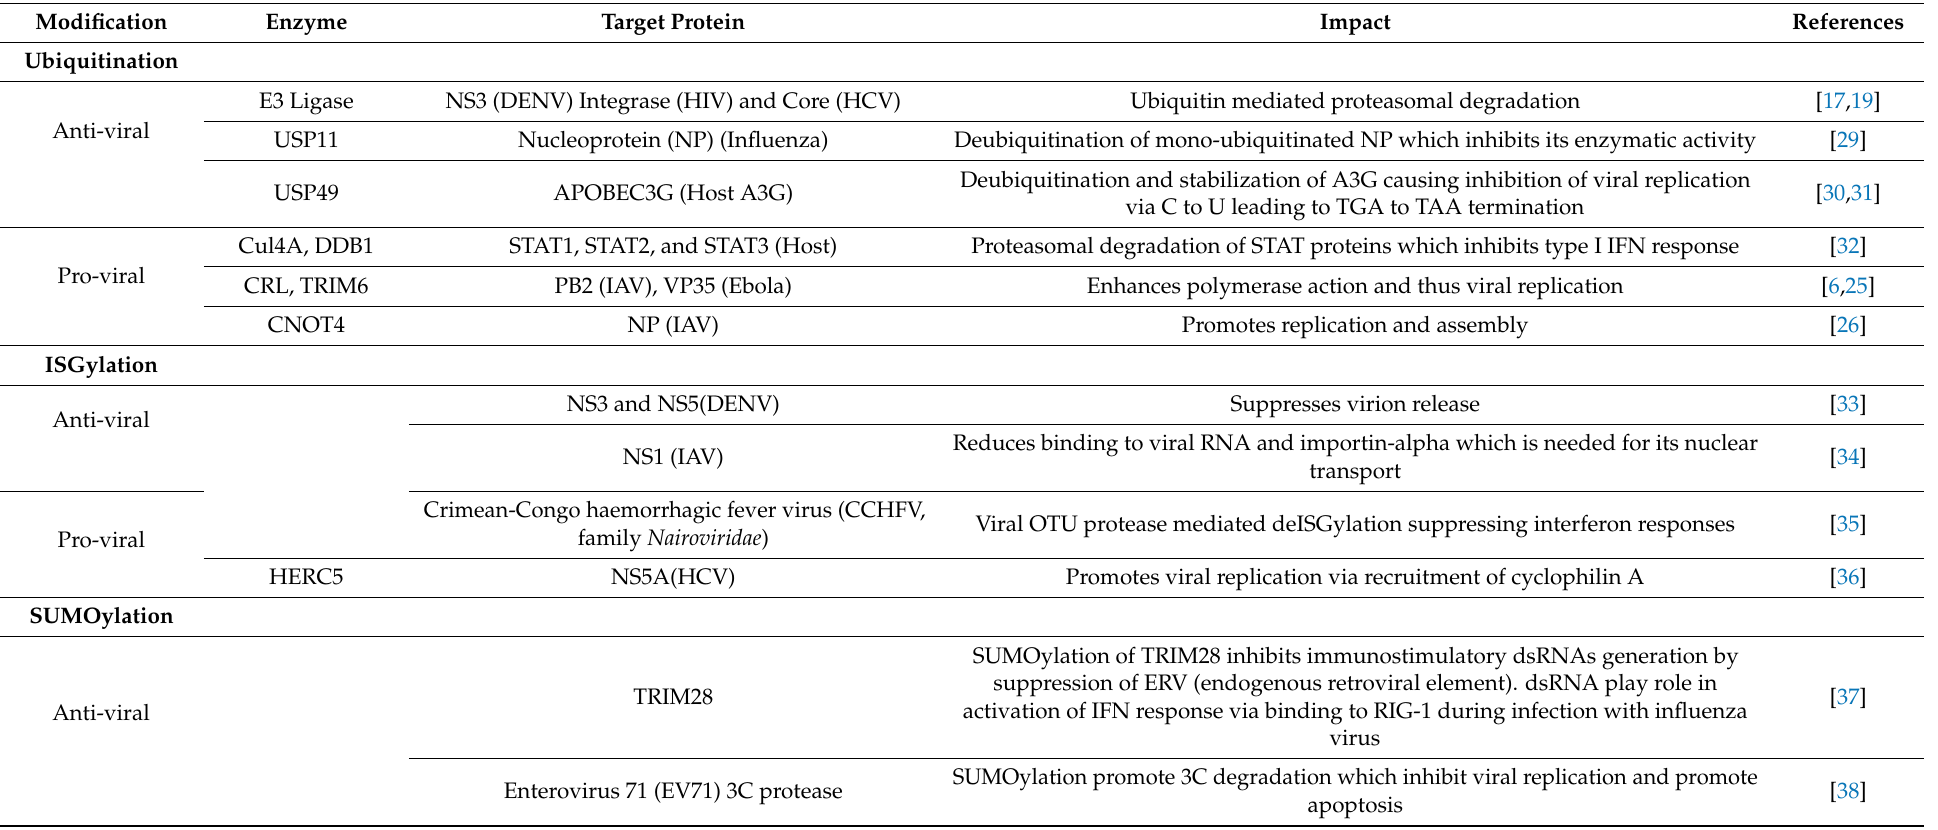
Table 1. PTMs and their role during viral